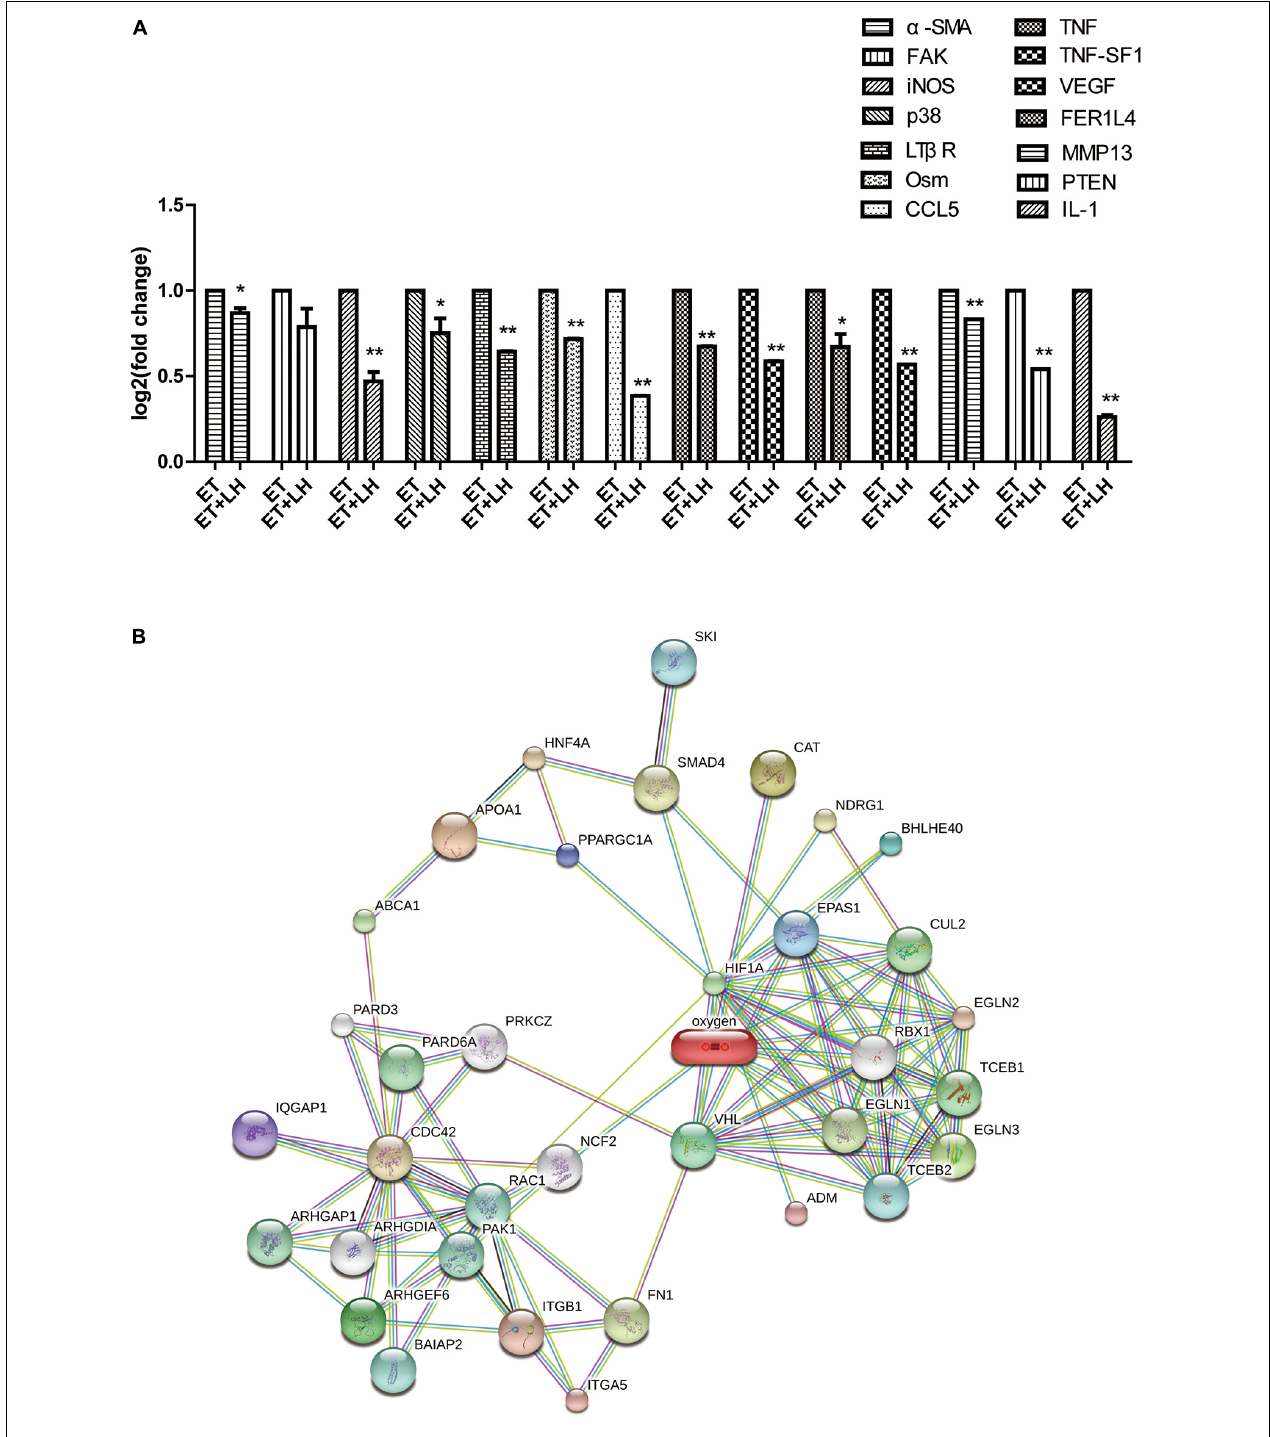
FIGURE 5 | The genes expression changes of Leonurine hydrochloride (LH) against alcoholic liver disease (ALD). (A) The expression changes of genes determined by Real-time qPCR (RT-qPCR). Ethanol-treated LO2 cells were exposed to LH (10 µ M) for 24 h. Then mRNA was extracted, the mRNA expressions were measured by RT-qPCR. * and ** indicated a significant difference at p < 0.05 level, a highly significant difference at p < 0.01 level, respectively, between ET group vs. ET + LH group using the independent t -test. (B) Protein-protein interaction network of LH acting on ALD. Small circles: protein of unknown 3D structure; large circles: some 3D structure is known or